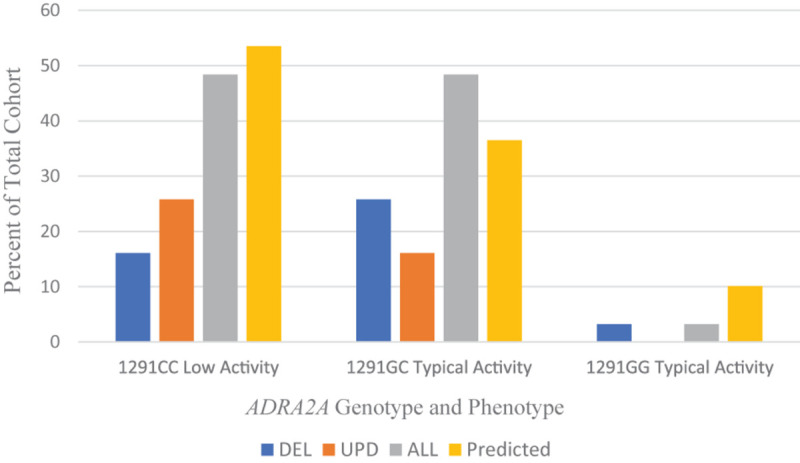
Frequencies of 1291C > G ADRA2A genotype and phenotype among PWS genetic subtypes DEL, UPD, and ALL (n = 31) compared to a predicted cohort of White Americans (n = 232) (Lima et al., 2007). DEL, deletion; UPD, uniparental disomy; ALL, combined cohort of PWS.